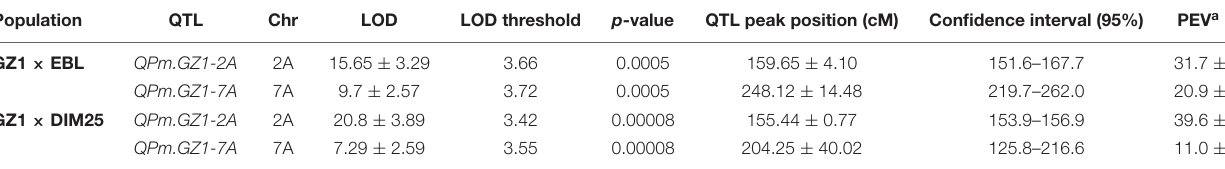
TABLE 3 | QTLs related to Pm resistance in the GZ1 × EBL and GZ1 × DIM25 mapping